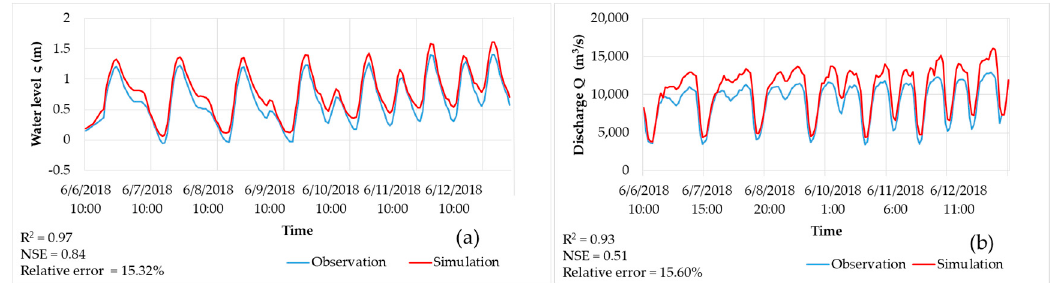
Figure 7. Observations and simulations at Tan Chau station from 10:00 6 June 2018 to 10:00 13 June 2018 for the water level ς (m) ( a ) and discharge Q (m 3 /s) ( b ).